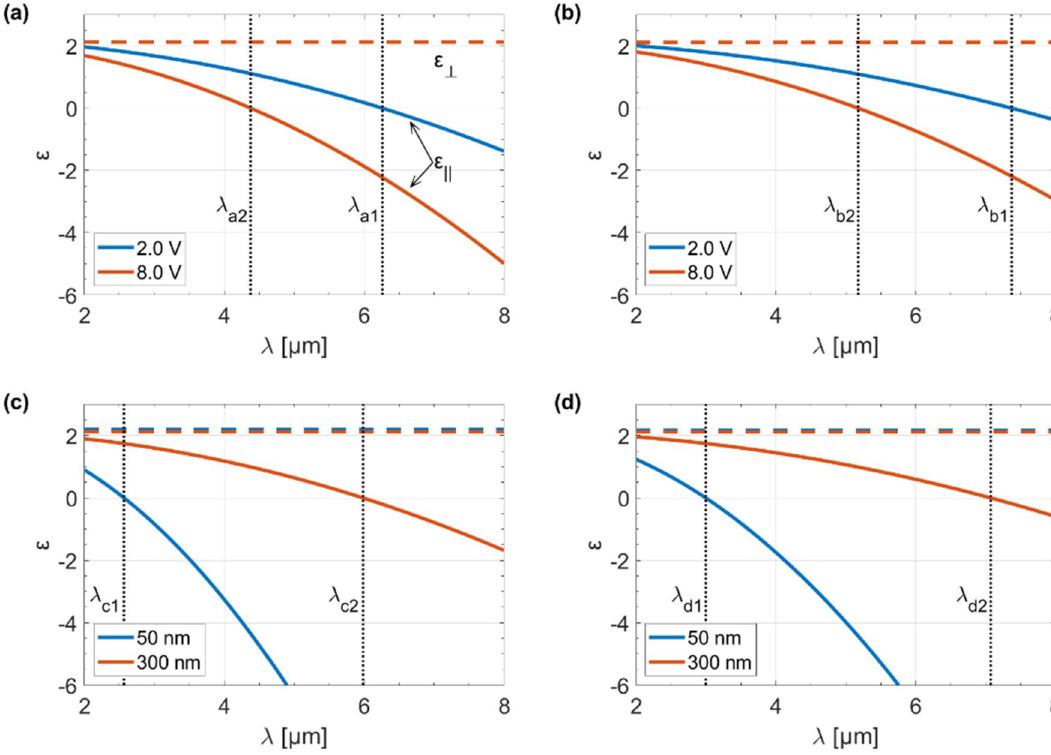
Figure 3. Real part of the permittivity tensor components as a function of a wavelength for different gate voltage ( V g ) for ( a ) unmodulated and ( b ) modulated structure and for different base dielectric thickness ( t 0 ) for ( c ) unmodulated and ( d ) modulated structure. Parallel permittivity components are denoted with solid lines while perpendicular components are denoted with dashed lines.